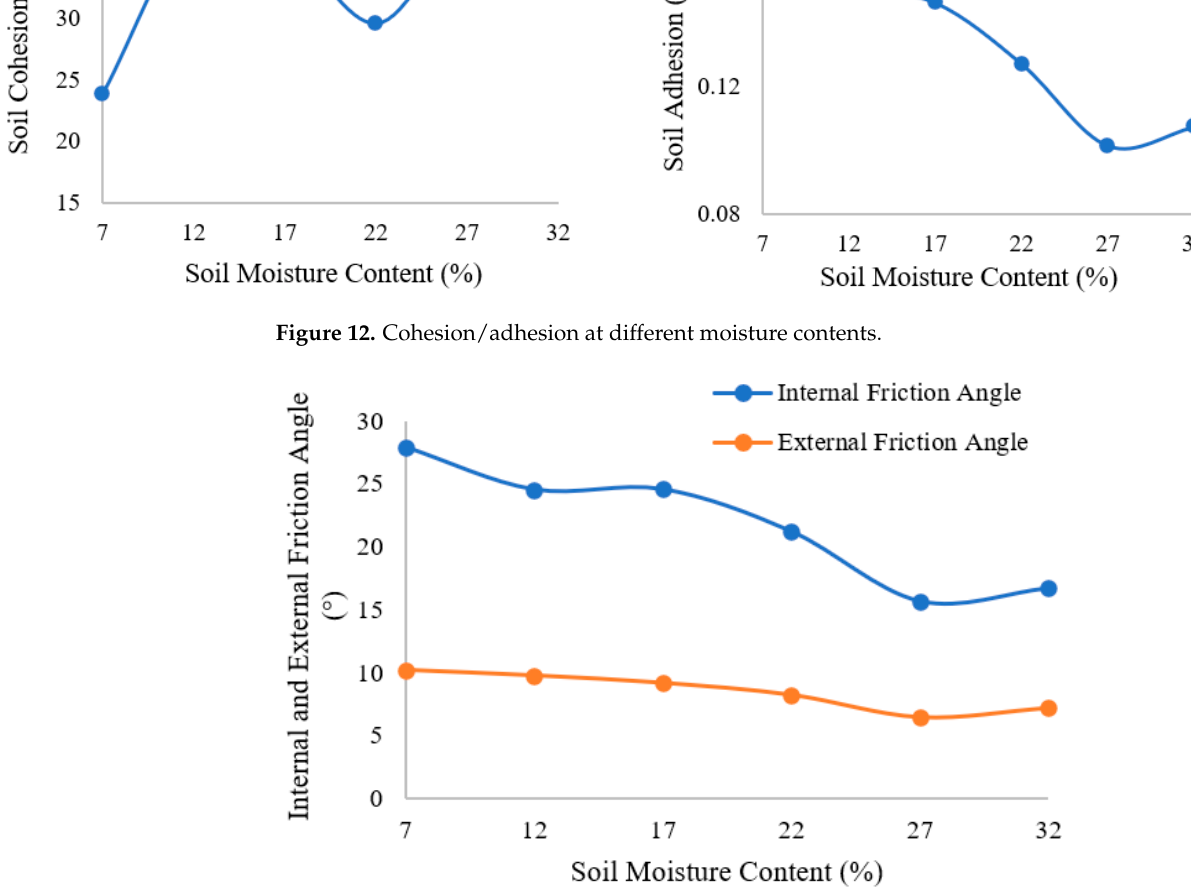
Figure 13. Internal/external friction angle at different moisture contents.